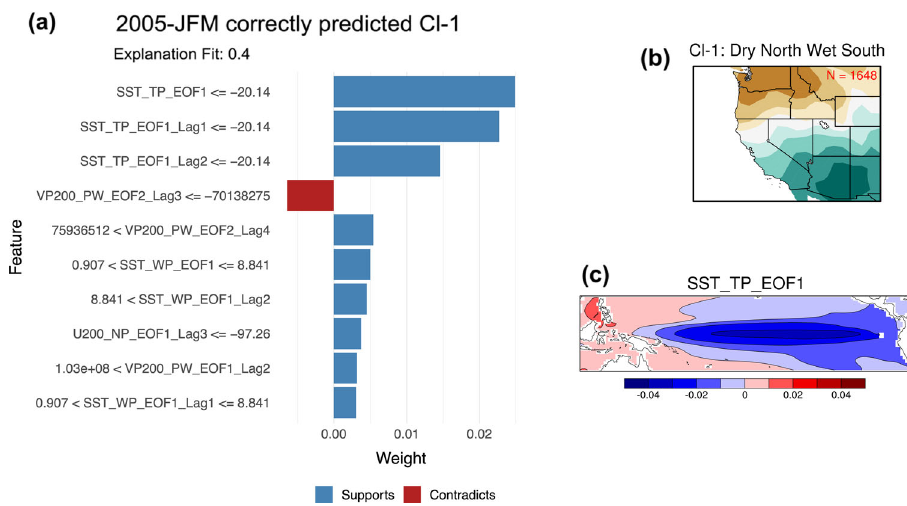
Fig. 8 Explaining individual seasonal forecasts through LIME modeling. Panel a shows which variables most strongly in fl uenced the 2005-JFM correct prediction of Cluster 1 (panel b ). Negative values of SST_TP_EOF and its lags (panel c ), corresponding to a warm tropical paci fi c under a weak El Niño event across October to December, most strongly favored the prediction of Cluster 1. Another LIME case study, for the incorrect 2016-JFM prediction case, is shown in Supplementary Material Fig.